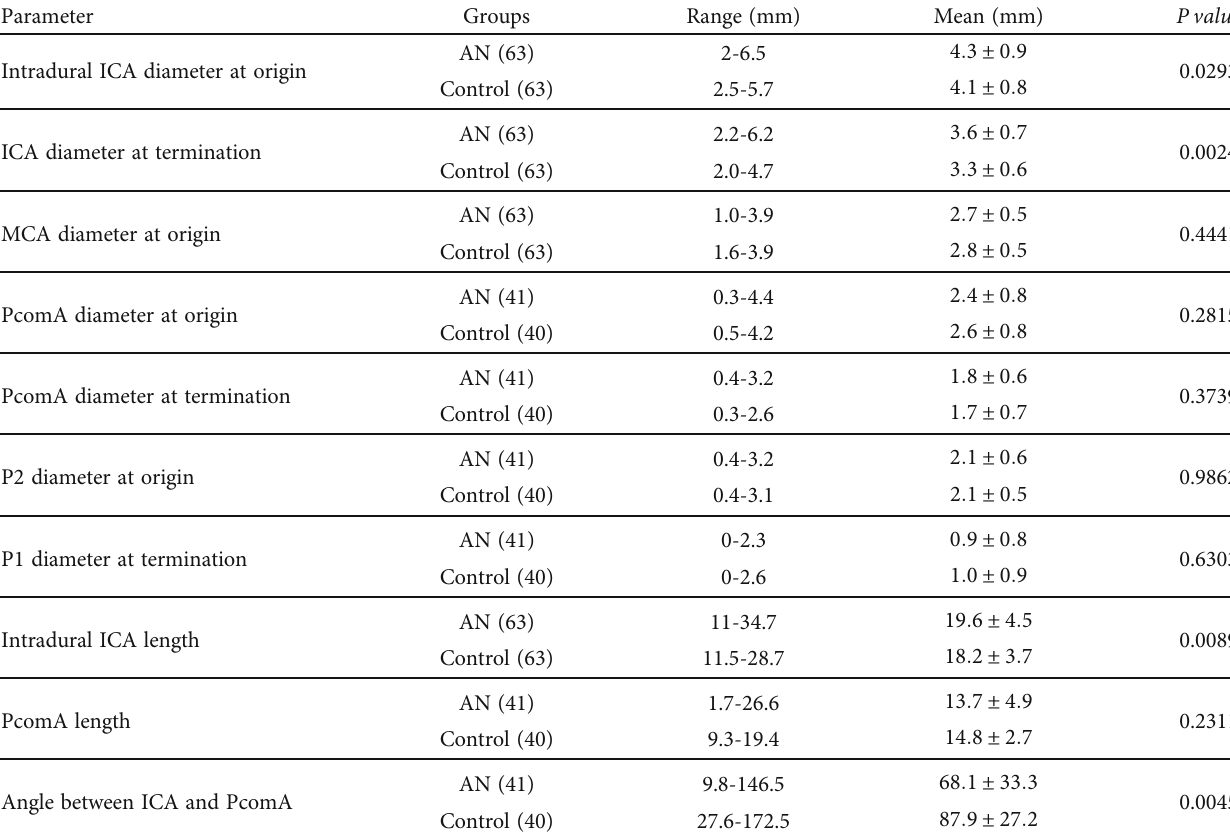
Table 2: Statistical analysis between the aneurysm and control groups.